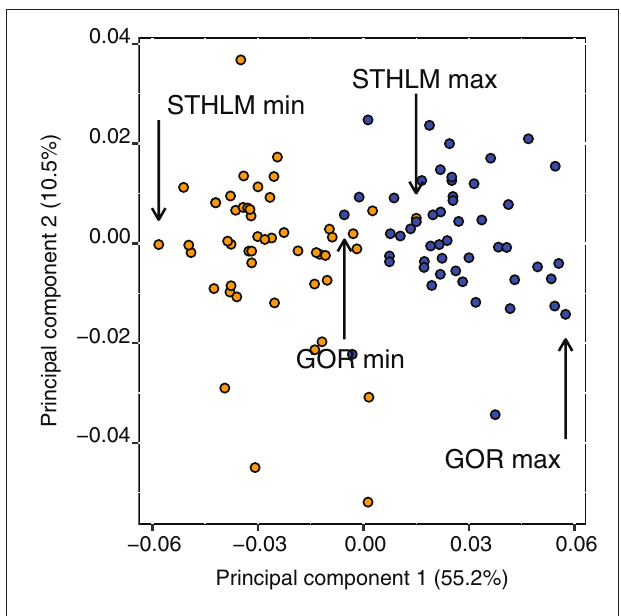
FIGURE 1 | Principal component axes 1 and 2 of shape variation of Procrustes aligned specimens for the STHLM (orange) and GOR (blue) E. affinis populations, individuals with minimum and maximum value on principal component 1 from the respective population are marked out. These individuals are depicted in Figure 2